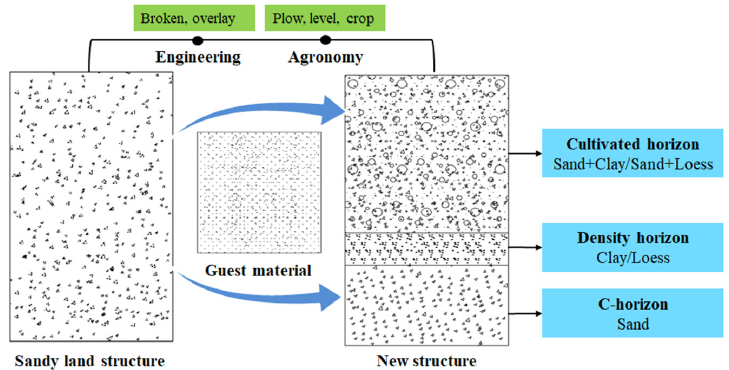
Figure 2. Comprehensive framework of sandy land structural consolidation practices.